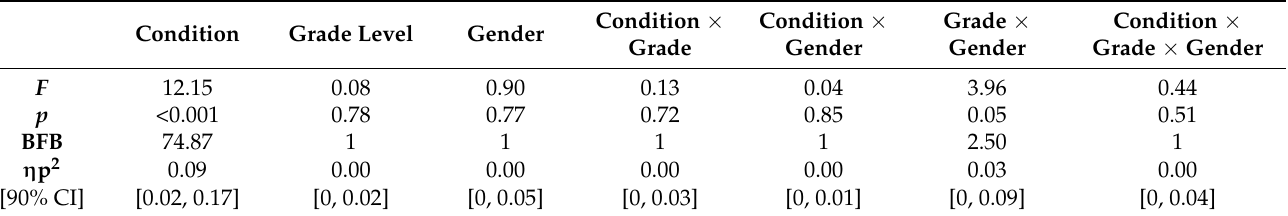
Table 4. Statistics for fixed effects (Condition, Grade Level and Gender) in univariate ANOVAs conducted on pseudoerror detection task.